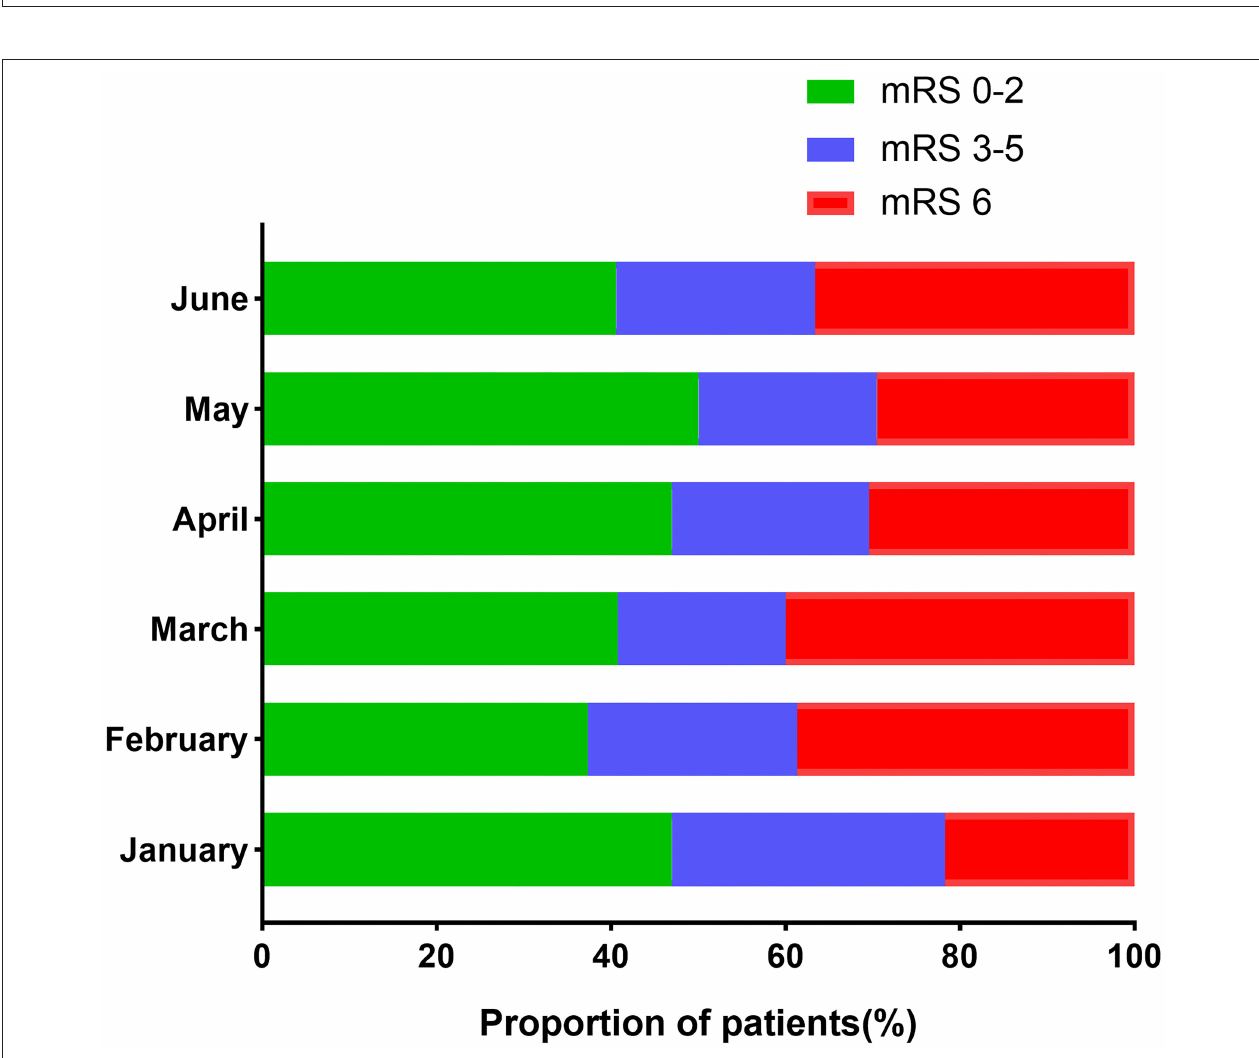
FIGURE 3 | The month-dependent proportion of patients with unadjusted 1-year outcomes in the 2020 group.